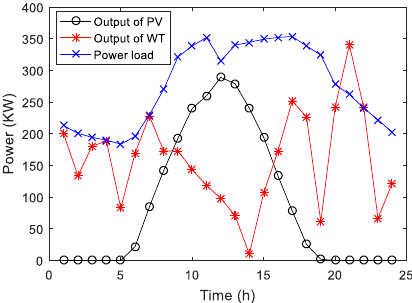
Y e s Y e s Figure 7. The flow chart of DSR. 5. Case Study 5.1. Case Parameters The maximum charging power of the battery is 600 kW. The initial power of the